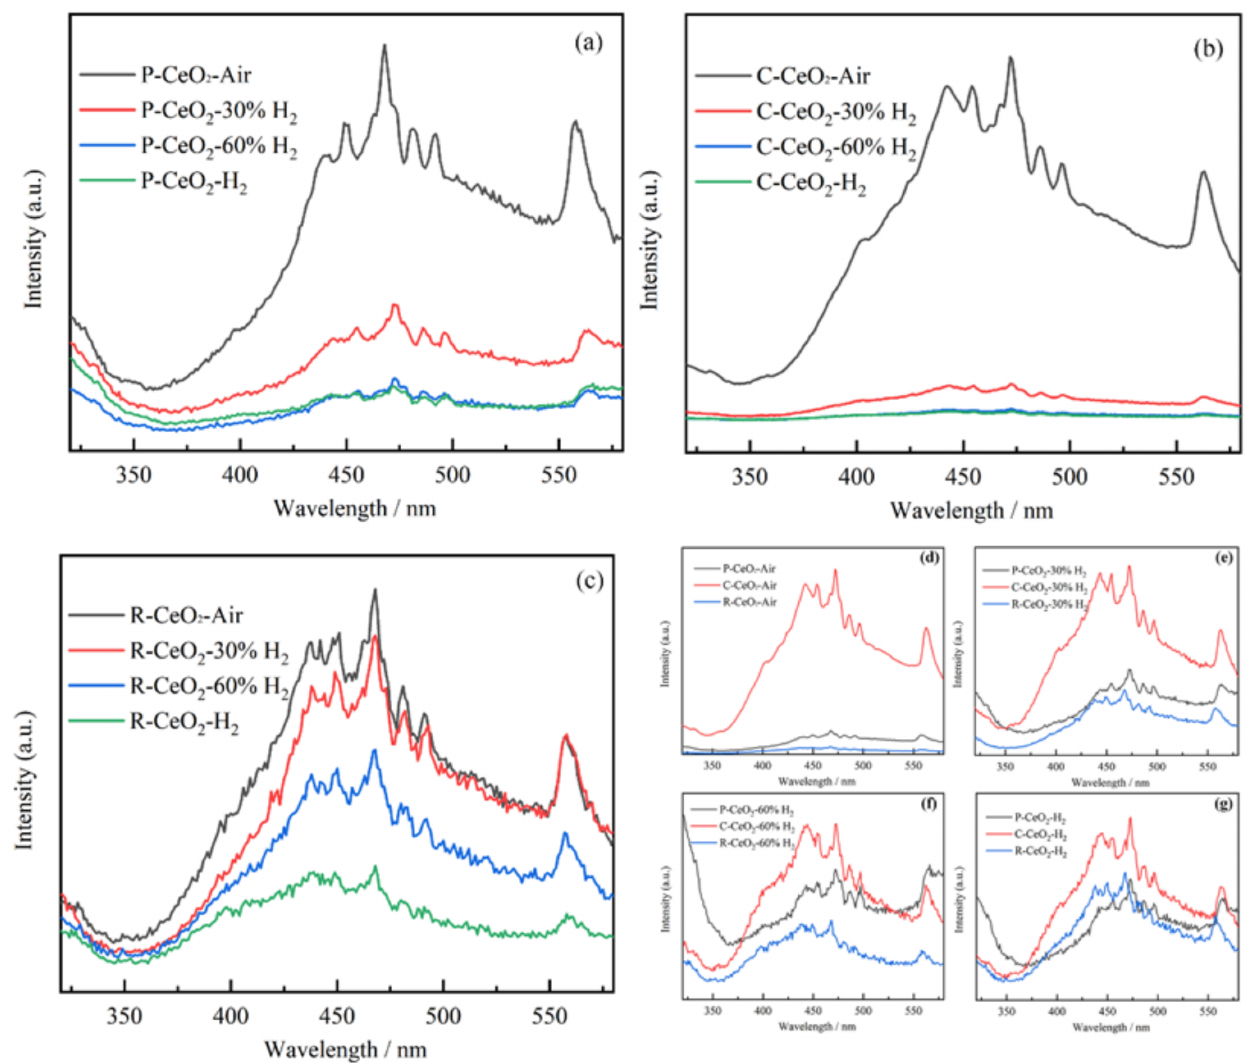
Figure 8. The PL spectra of annealed P-CeO 2 ( a ), C-CeO 2 ( b ), R-CeO 2 ( c ) and the samples annealed in same condition ( d – g